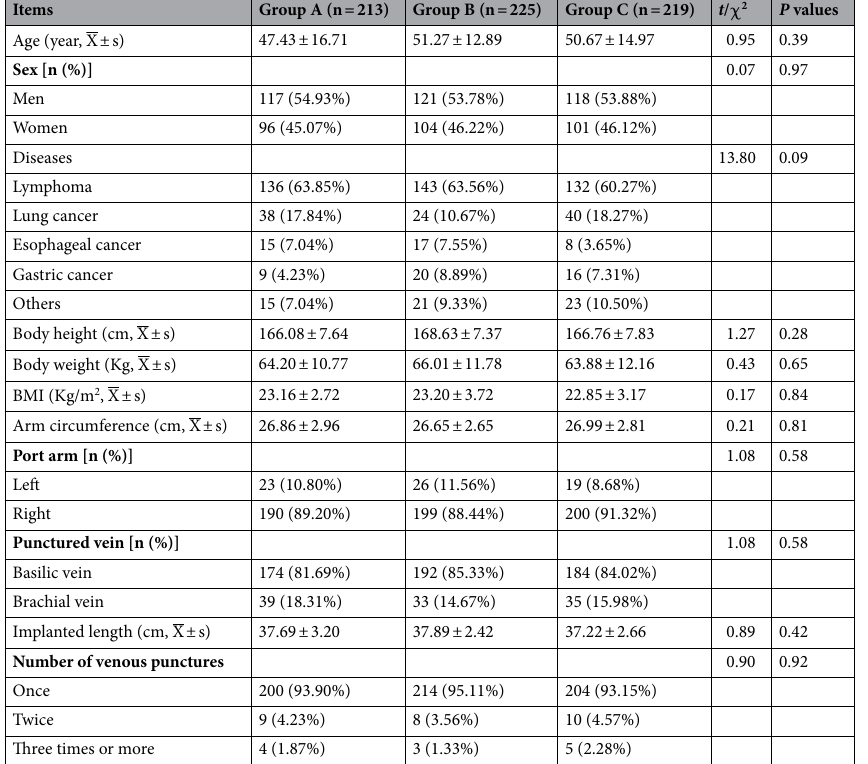
Table 1. General data of patients in the three groups. BMI body mass